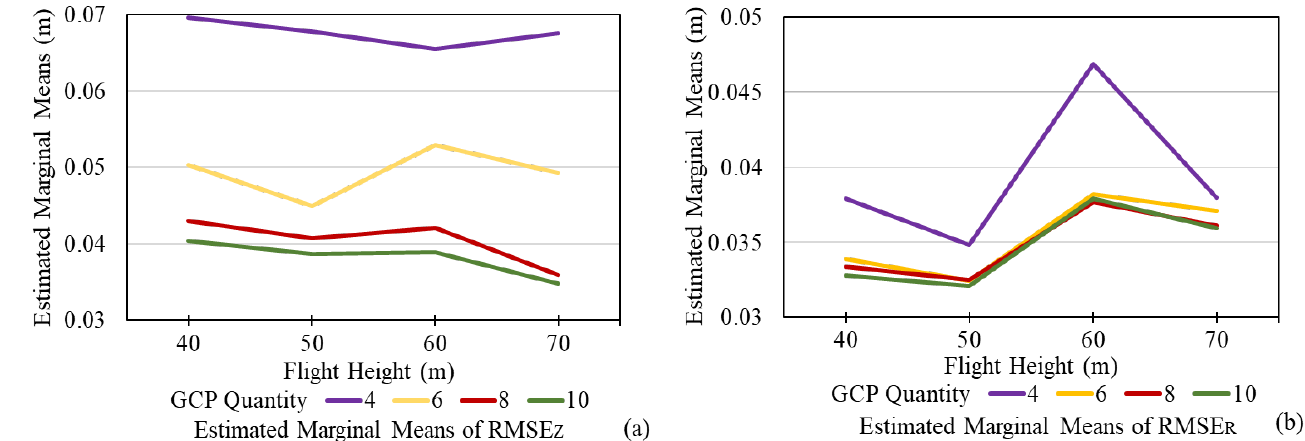
Figure 14. Interaction between Flight Height and GCP Quantity; ( a ) RMSE Z ; ( b ) RMSE R.